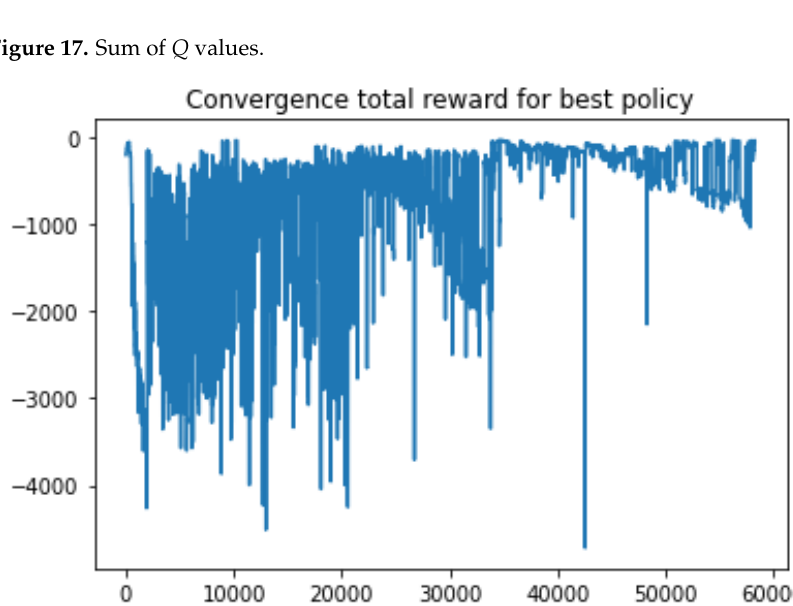
Figure 18. Convergence total reward for best